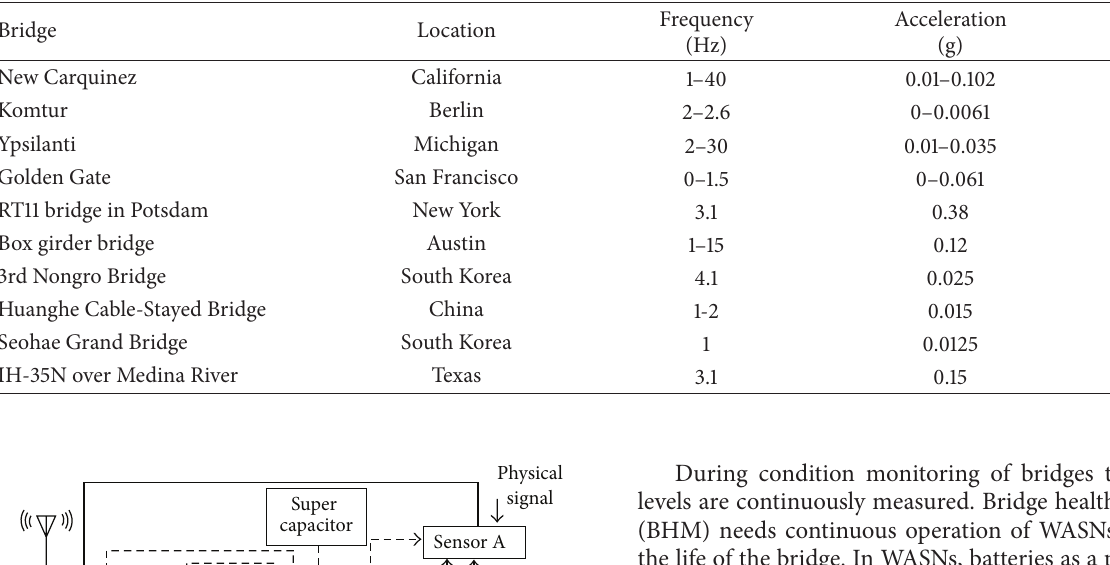
Table 2: Summary of bridge vibration data.